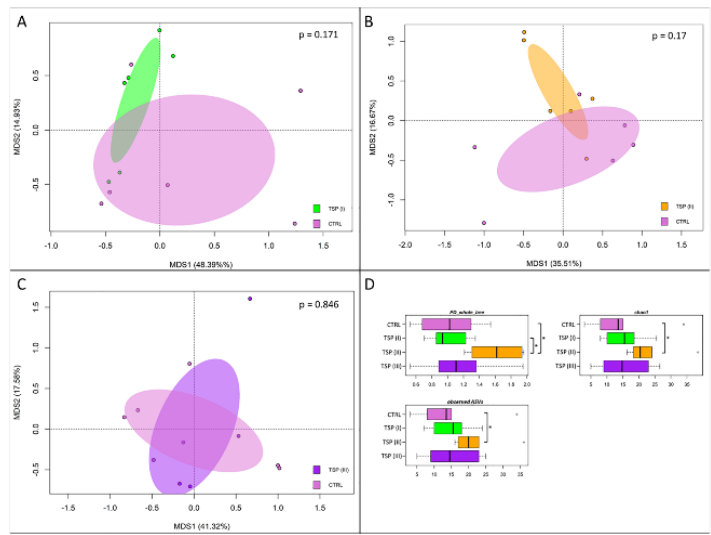
Figure 5. Beta diversity and alpha diversity of the gut microbiota of zebrafish fed a control diet (CTRL), zebrafish fed a diet supplemented with TSP at 0.9 g/kg of feed (TSP I), zebrafish fed a diet supplemented with TSP at 1.7 g/kg of feed (TSP II), and zebrafish fed a diet enriched with TSP at 3.4 g/kg of feed (TSP III). PCoA based on unweighted UniFrac distances between gut microbiota struc- tures of CTRL zebrafish and TSP I ( A ), TSP II ( B ), and TSP III ( C ) zebrafish. In all PCoA plots, sam-